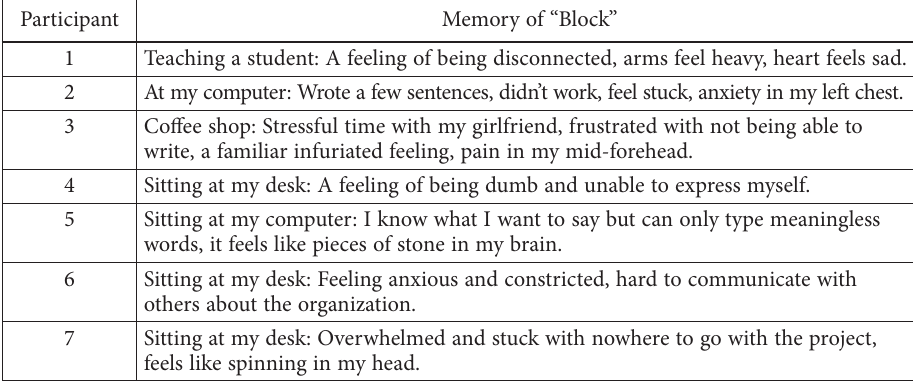
Table 2. Participants’ memories – employed in session 1 (induction) (source: created by author) Participant Memory of “Block”